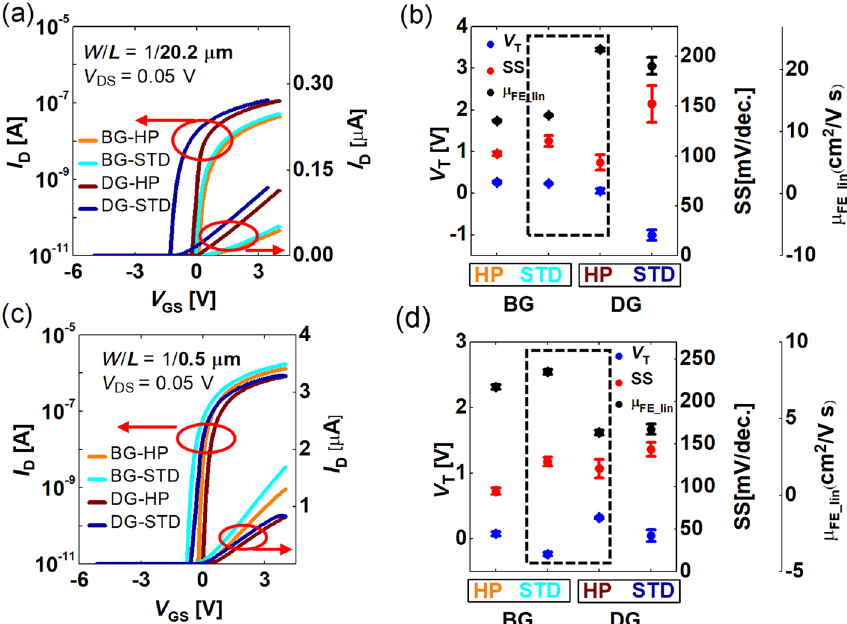
Figure 2. The ( a ) transfer characteristics and ( b ) device parameters (i.e., V T , SS, and μ FE ) of long-channel IGZO FETs ( L = L BG = 20.2 μm and L TG = 20 μm). The ( c ) transfer characteristics and ( d ) device parameters of short- channel IGZO FETs ( L = L BG = 0.5 μm and L TG = 0.3 μm). Error bar was taken from five device